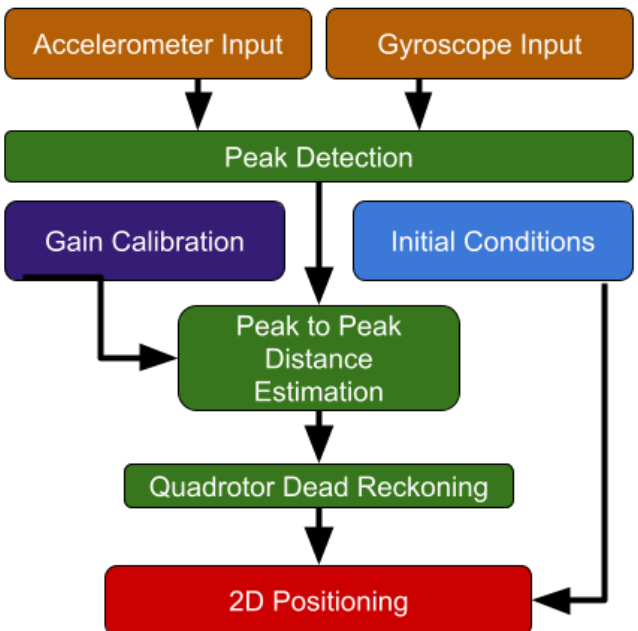
Figure 2. Block diagram of the quadrotor dead reckoning